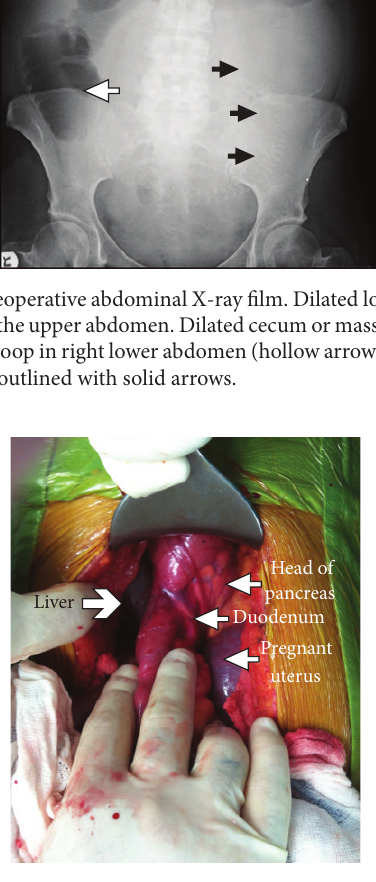
Figure 4: Illustration of the anatomical situation. The entire colon failed to move anteriorly to superior mesenteric axis during embryonic life. The transverse colon is positioned behind the root of mesentery in a rertroarterial position. The site of obstruction is marked with an